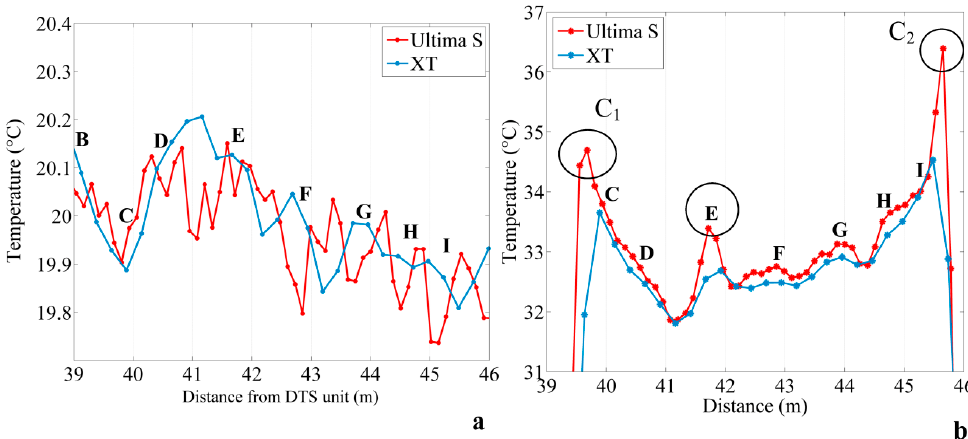
Figure 4. ( a ) Example of temperature profiles measured with the XT DTS (Distributed Temperature Sending) unit and the Ultima DTS unit in the sandbox at a non-heated time ( b ) Example of temperature profiles measured with the XT DTS and the Ultima DTS unit in the sandbox at a heated time, after temperature stabilization.